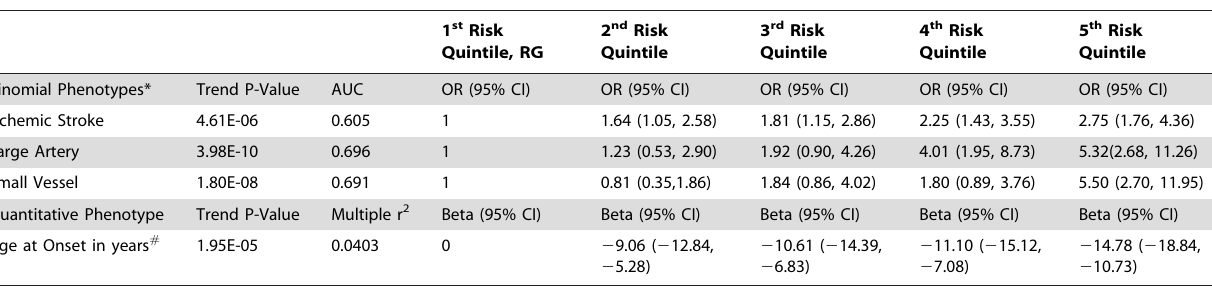
Table 1. Risk profile estimates for phenotypes of interest.